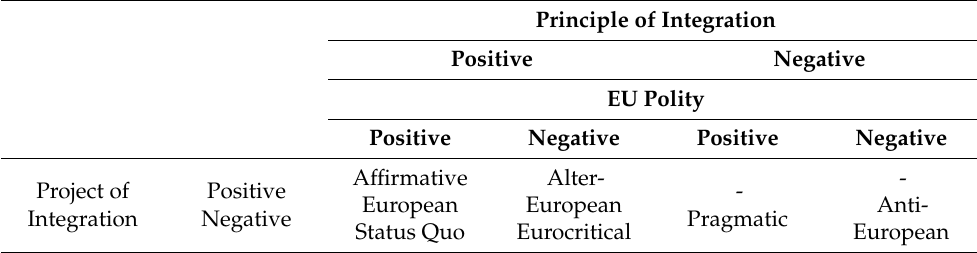
Table 1. Typology of EU polity